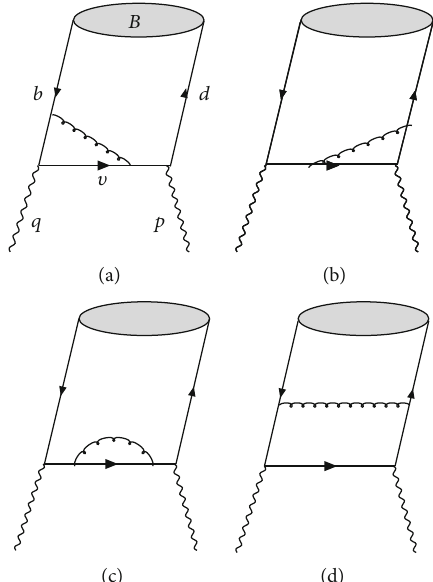
Figure 1: Diagrammatic representation of the correlation function Π